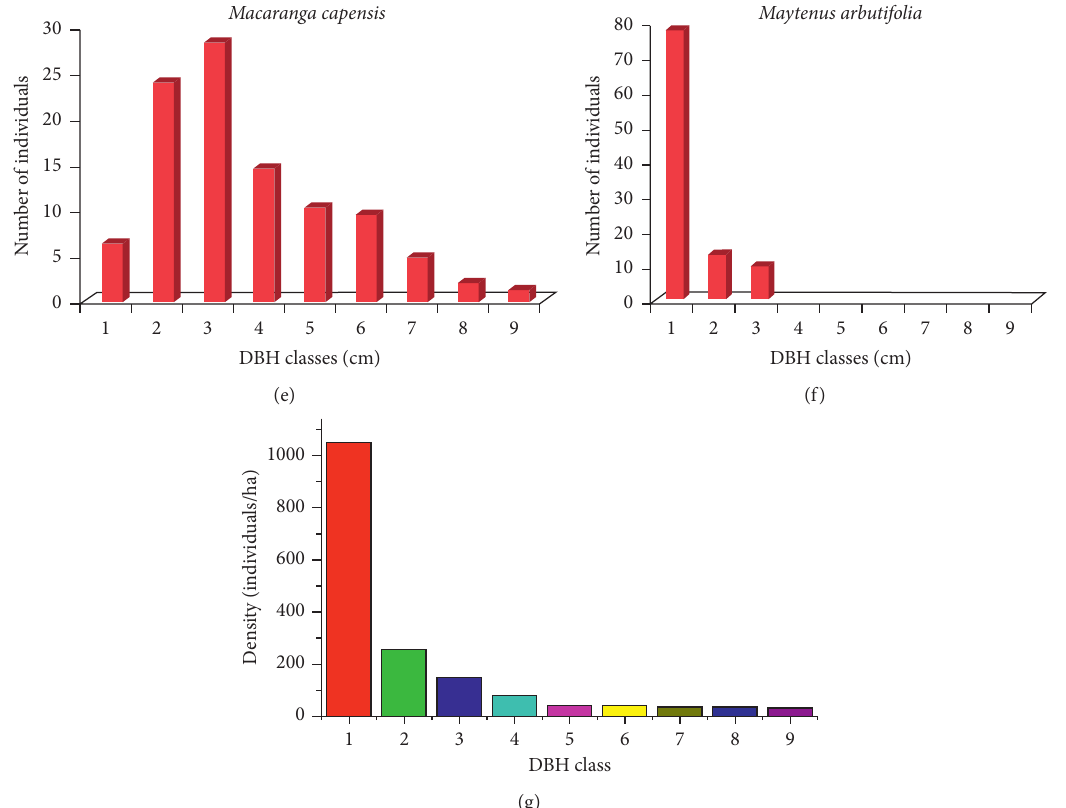
Figure 8: Population structures of representative species (a)–(f) and the overall pattern of population structure of Wurg forest (g): class 1 (2.5–12.5 cm), 2 (12.6–22.5cm), 3 (22.6–32.5cm), 4 (32.6–42.5cm), 5 (42.6–52.5cm), 6 (52.6–62.5cm), 7 (62.6–72.5cm), 8 (72.6–82.5cm), and 9 > (82.5